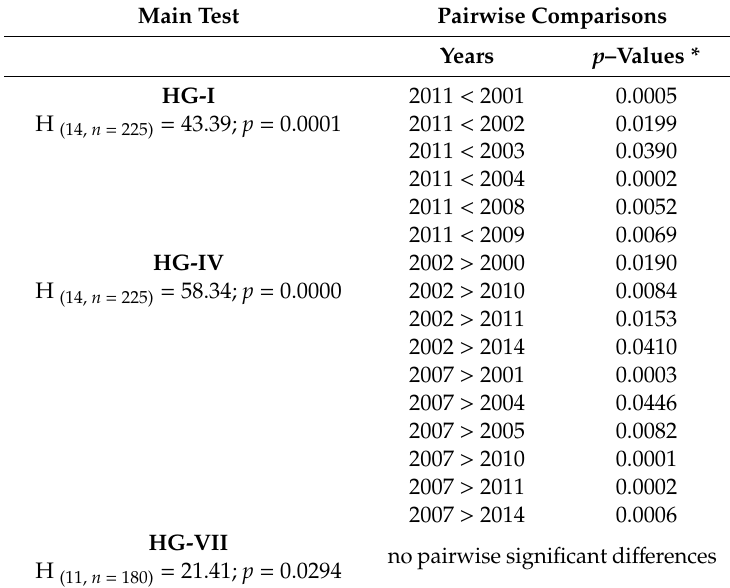
Table 3. Results of the Kruskal-Wallis-Test for di ff erences in total meiofauna abundance between years at HG-I, HG-IV, and HG-VII (left) and a post-hoc test for multiple comparisons between years (right) (* Bonferroni-corrected p -values; only years with significant di ff erences in meiofauna abundance are reported). Main Test p –Values